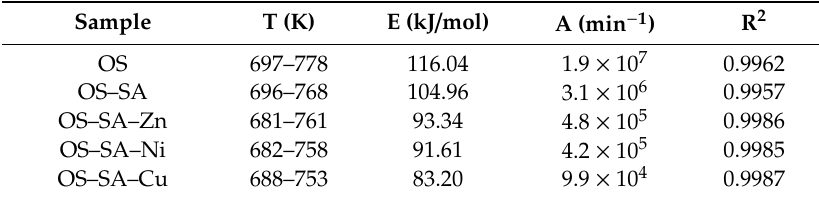
Table 3. Thermal kinetic parameters of oil shale with and without catalyst.